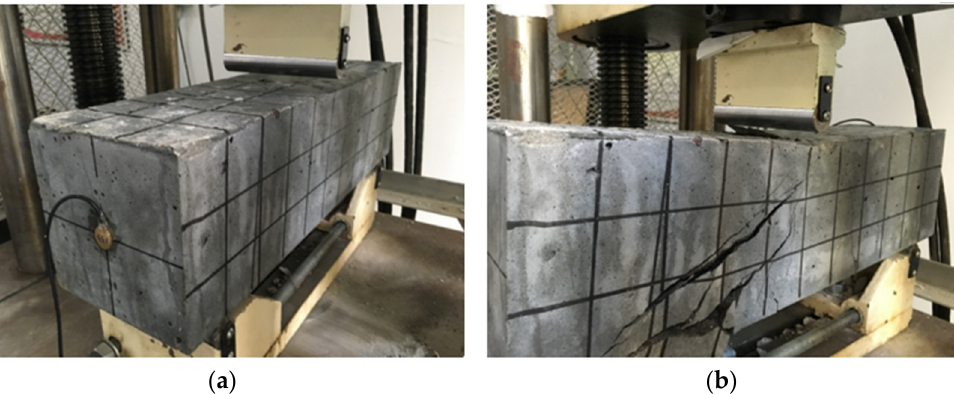
Figure 15. Test procedure ( a ) initial condition ( b ) collapse at load of 120.95 kN.